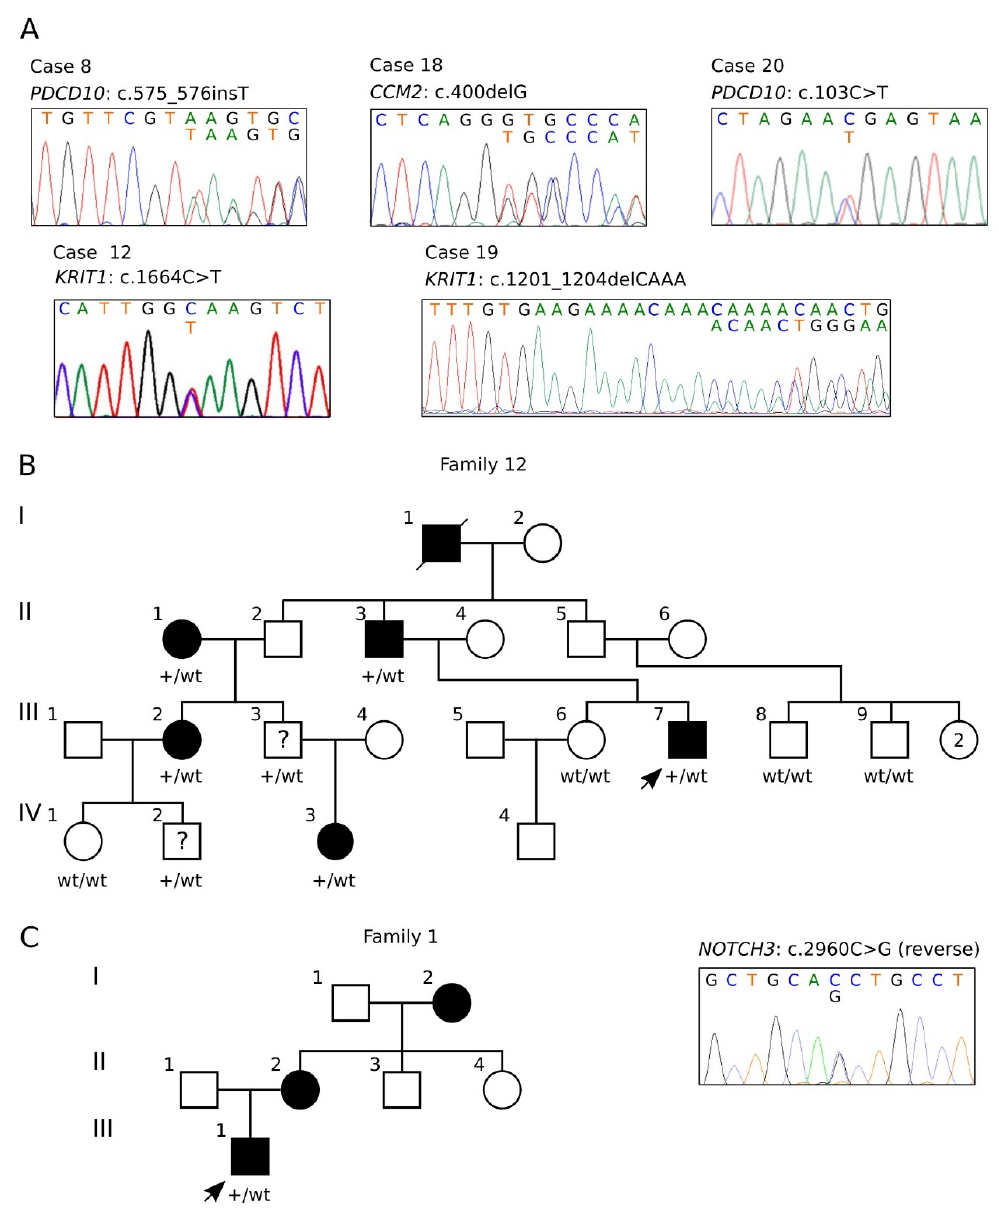
Figure 1. Sanger validation and pedigrees. ( A ) Electropherograms of the identified CCM gene variants reported in Table 2. ( B ) Four-generation pedigree of family 12. Filled symbols indicate affected subjects; a question mark indicates the subjects carrying the pathogenic variant but without signs of disease. The genotype is indicated below each tested subject (wt/wt, homozygous wild type; wt/+, heterozygote for the KRIT1 c.1664C>T variant. ( C ) Pedigree of family 1 (left) and electropherogram of the identified NOTCH3 c.2960C>G variant (right).